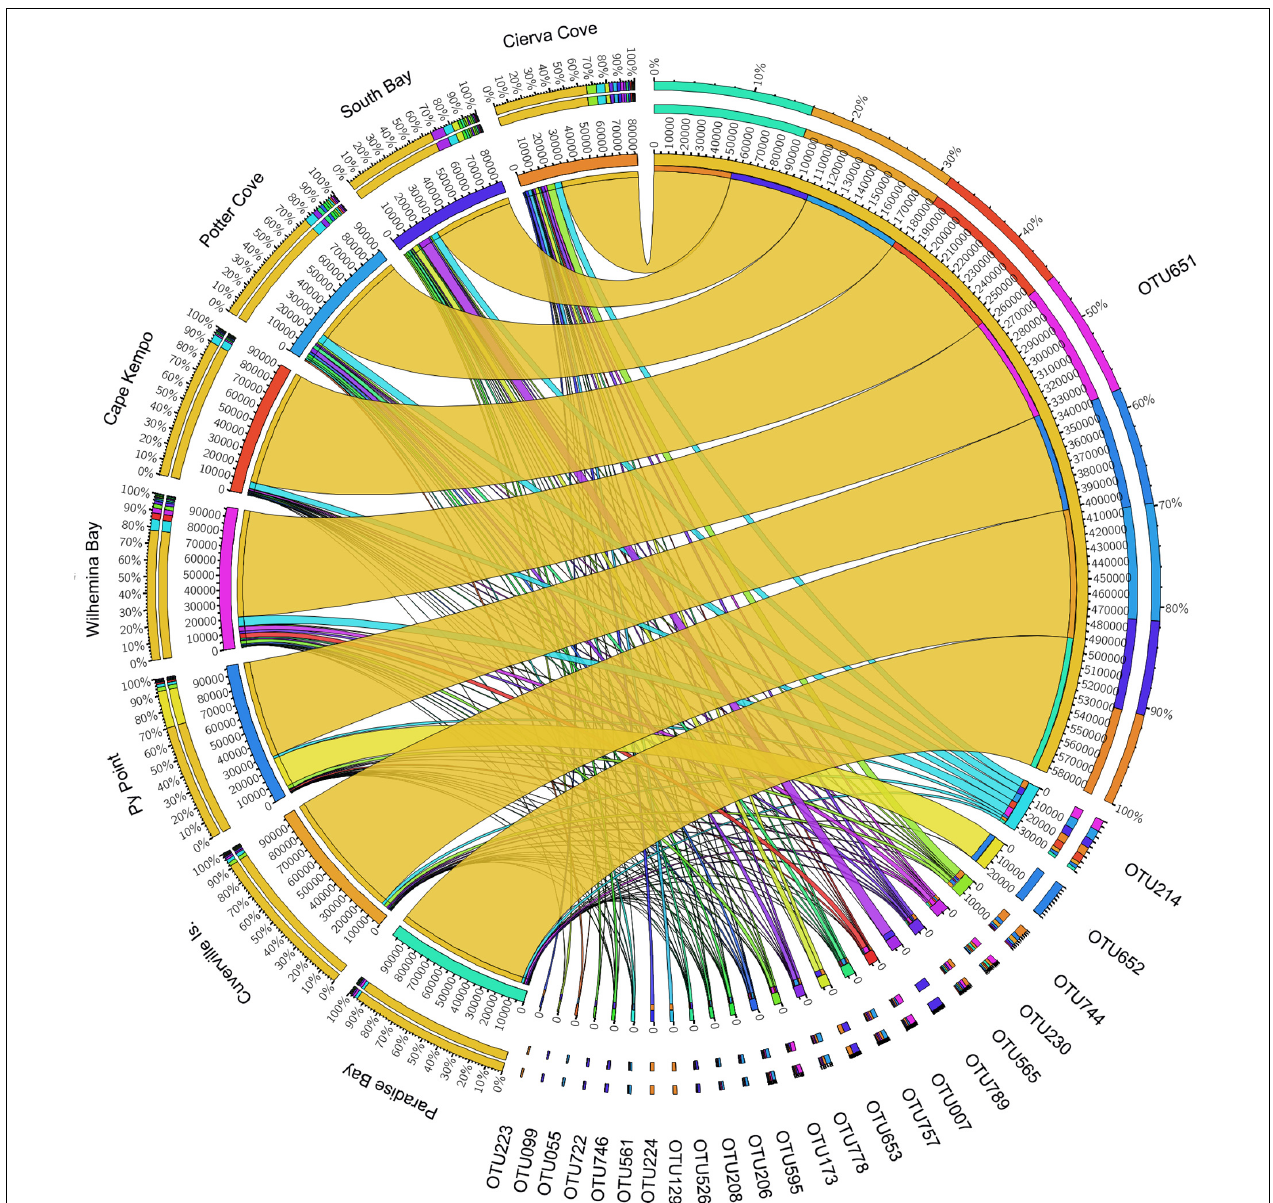
FIGURE 4 | Relative abundances of microbial OTUs associated with the sponge M. acerata sampled at different sites along the WAP. The circos plot displays the relative abundance of most abundant prokaryotic OTUs from M. acerata samples collected at the different localities. The plot was generated from OTUs with at least 1% of relative abundance in at least one sponge sample. Values were multiplied by 1,000 and rounded without decimals in order to perform the circos plot analysis. The relative abundance of each OTU is directly proportional to the width of each ribbon connecting prokaryotic taxa to its respective sample. Each OTU is assigned a specific colour. The inner ring represents the total relative abundances (multiplied by 100) for a specific taxon and the proportion assigned to each locality. The outer ring represents the percentage of each taxon assigned to each